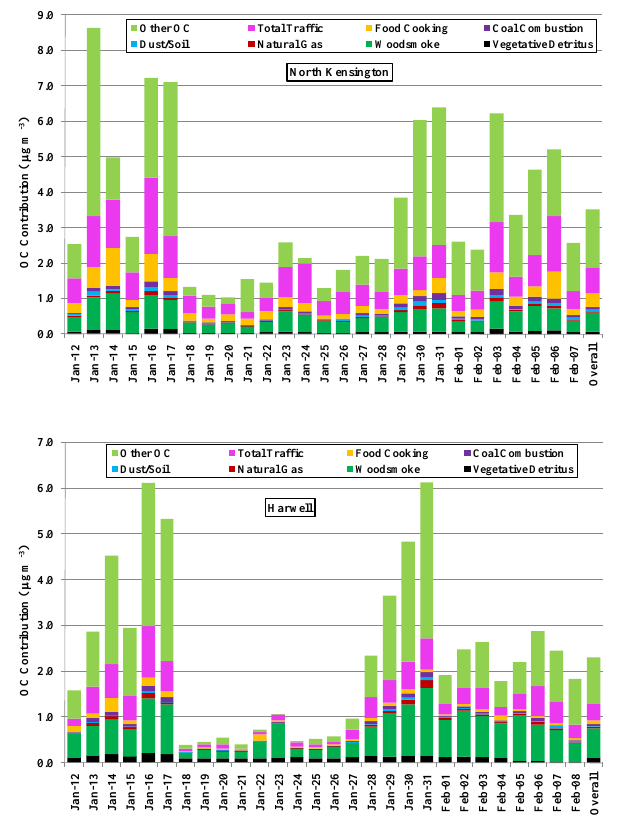
Figure 1. Daily OC source contributions at NK and HAR (without secondary biogenic component identified separately).